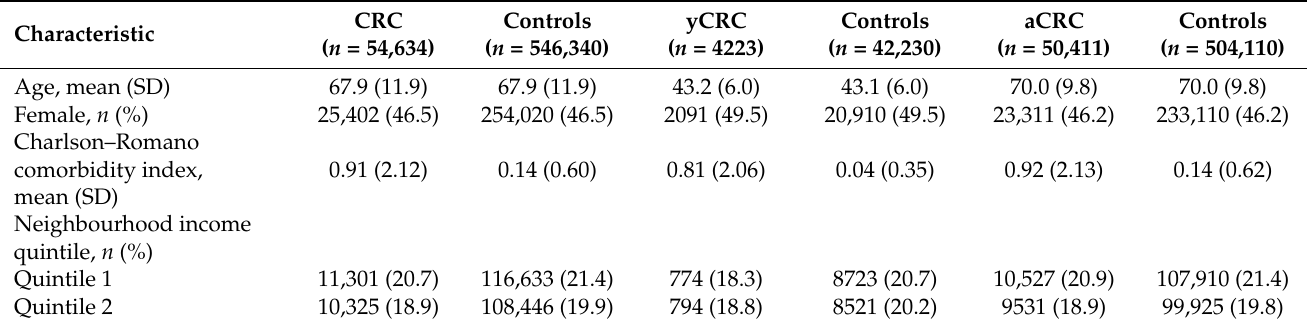
Table 1. Characteristics of individuals with colorectal cancer (CRC), young-onset colorectal cancer